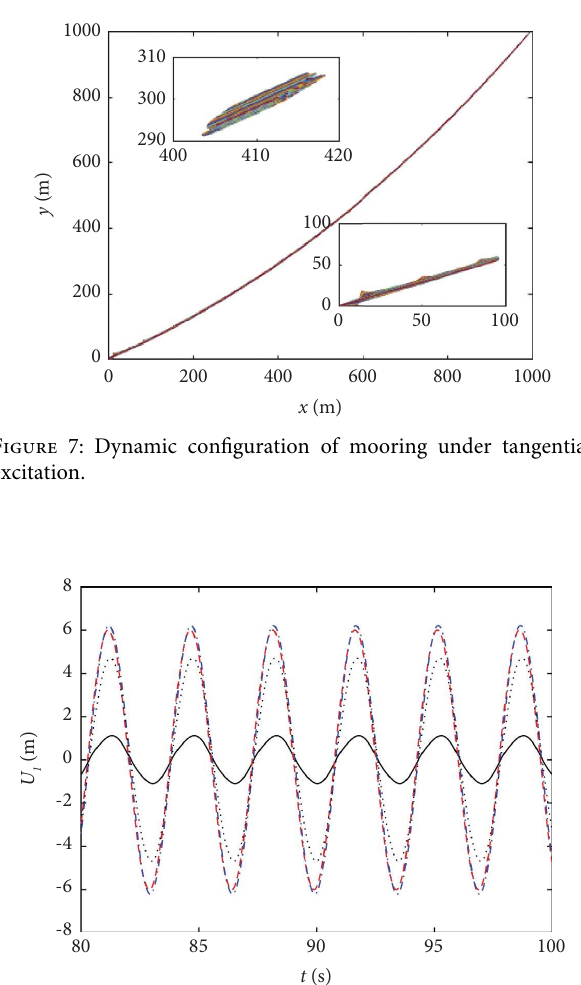
1 , A 2 , A 3 , and A 4